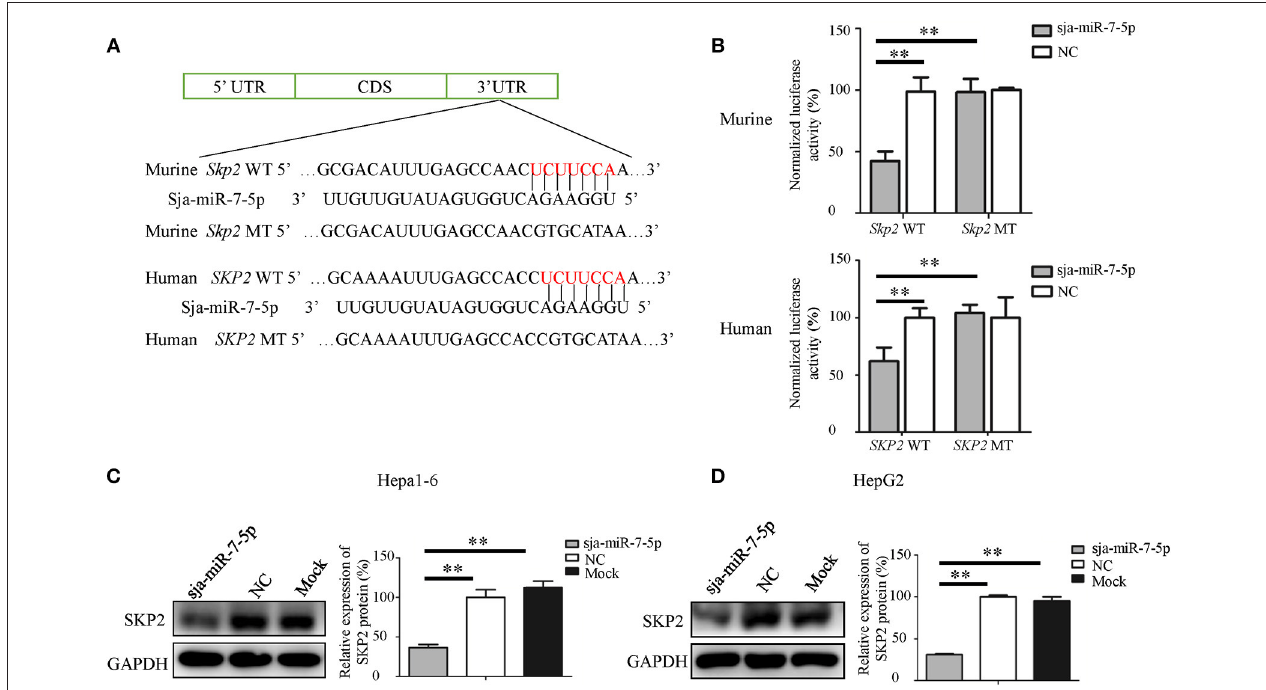
FIGURE 4 | SKP2 (encoding S-phase kinase-associated protein 2) is a direct target of sja-miR-7-5p. (A) A schematic diagram representing the wild-type or mutant 3’ untranslated region (UTR) sites of murine Skp2 and human SKP2 genes targeted by sja-miR-7-5p. (B) A dual-luciferase reporter assay was used to measure the activity of the reporter gene, and the firefly luciferase activity was normalized to renilla luciferase activity. (C,D) The protein levels of murine SKP2 (C) and human SKP2 (D) were measured using western blotting after transfection with sja-miR-7-5p mimics or NC mimics, respectively. Data are presented as the mean ± SD, n = 3, ** p <